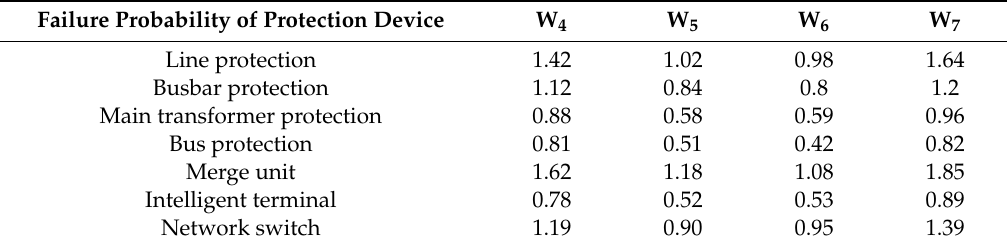
Table 2. Failure probability of protection device (10 − 4 h − 1 ).